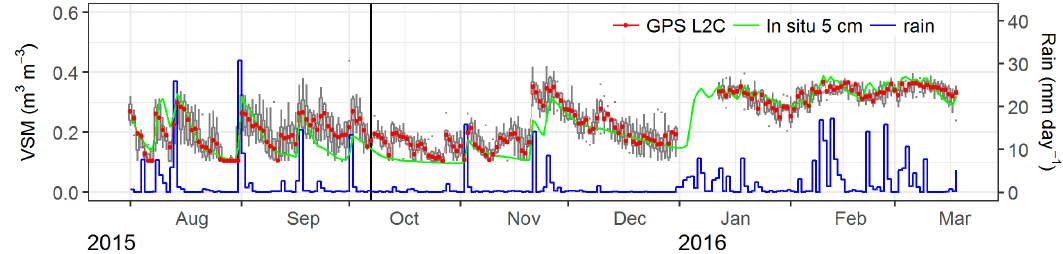
Figure 4. Median of the daily VSM retrievals ( N = 220, red dots) and their daily statistical distribution (grey box plots) for six available satellite tracks. Daily mean in situ VSM observations at a depth of 5cm are shown by the green line. The black line indicates the grass cutting before 7 October 2015. The blue line represents the rainfall (daily precipitation in mmday − 1 ) . The L2C SNR data acquired by the 29.4m antenna with a 10s sampling interval were used to retrieve VSM during TS1 (vegetation senescence and after cutting). Boxes: 25th– 75th percentiles; bars: maximum (minimum) values below (above) 1.5 IQR (interquartile range; corresponding to the 25th–75th percentile interval); dots: data outside the 1.5 IQR interval.